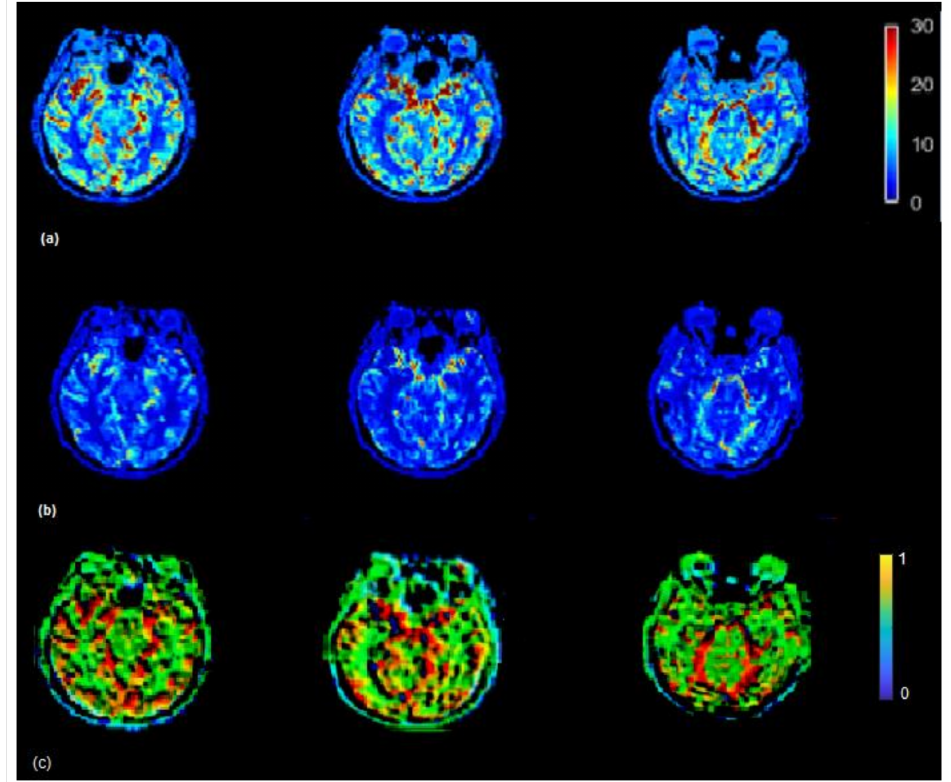
Figure 5. ( a ) CBF (mL/100 g/min) map generated by using rescaled AIF ( b ) and non-rescaled AIF (bottom). CBF map generated using rescaled AIF represents increased CBF values in the shown axial brain slices. CBF maps from non-rescaled AIF display mostly all the ROIs with decreased blood flow which makes it difficult to locate the regions which actually have a decreased flow. CBF images derived using rescaled AIF display ROIs with increased flow (red color) which helps to segregate the regions with decreased blood flow. This may help clinicals to identify the infract regions as well as regions with decreased blood flow on visual brain CBF images. ( c ) Maps illustrating the ratio between CBF values derived from the scaled and the non-scaled